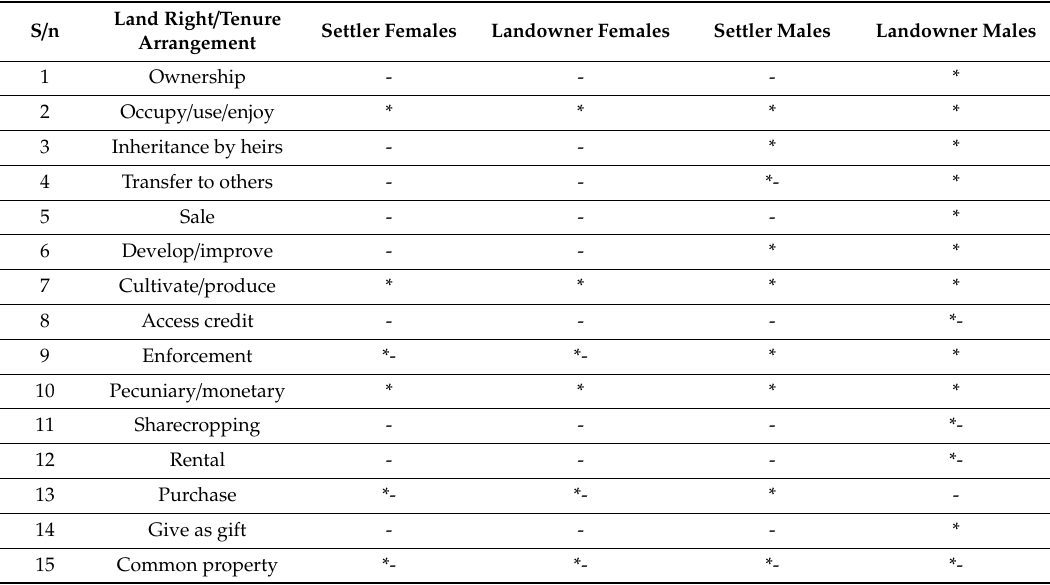
Table 4. Type of group land rights & tenure